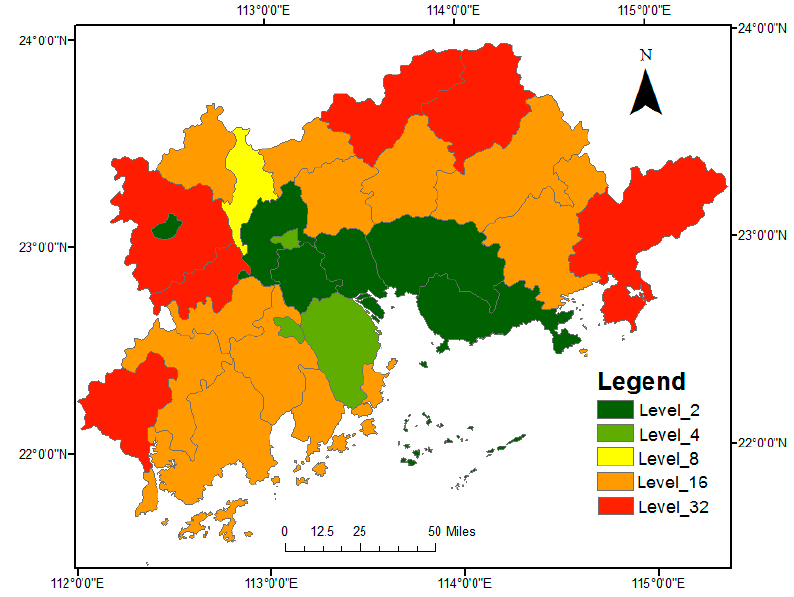
Figure 11. The peaks of scale variance in different cities of the Pearl River Delta.